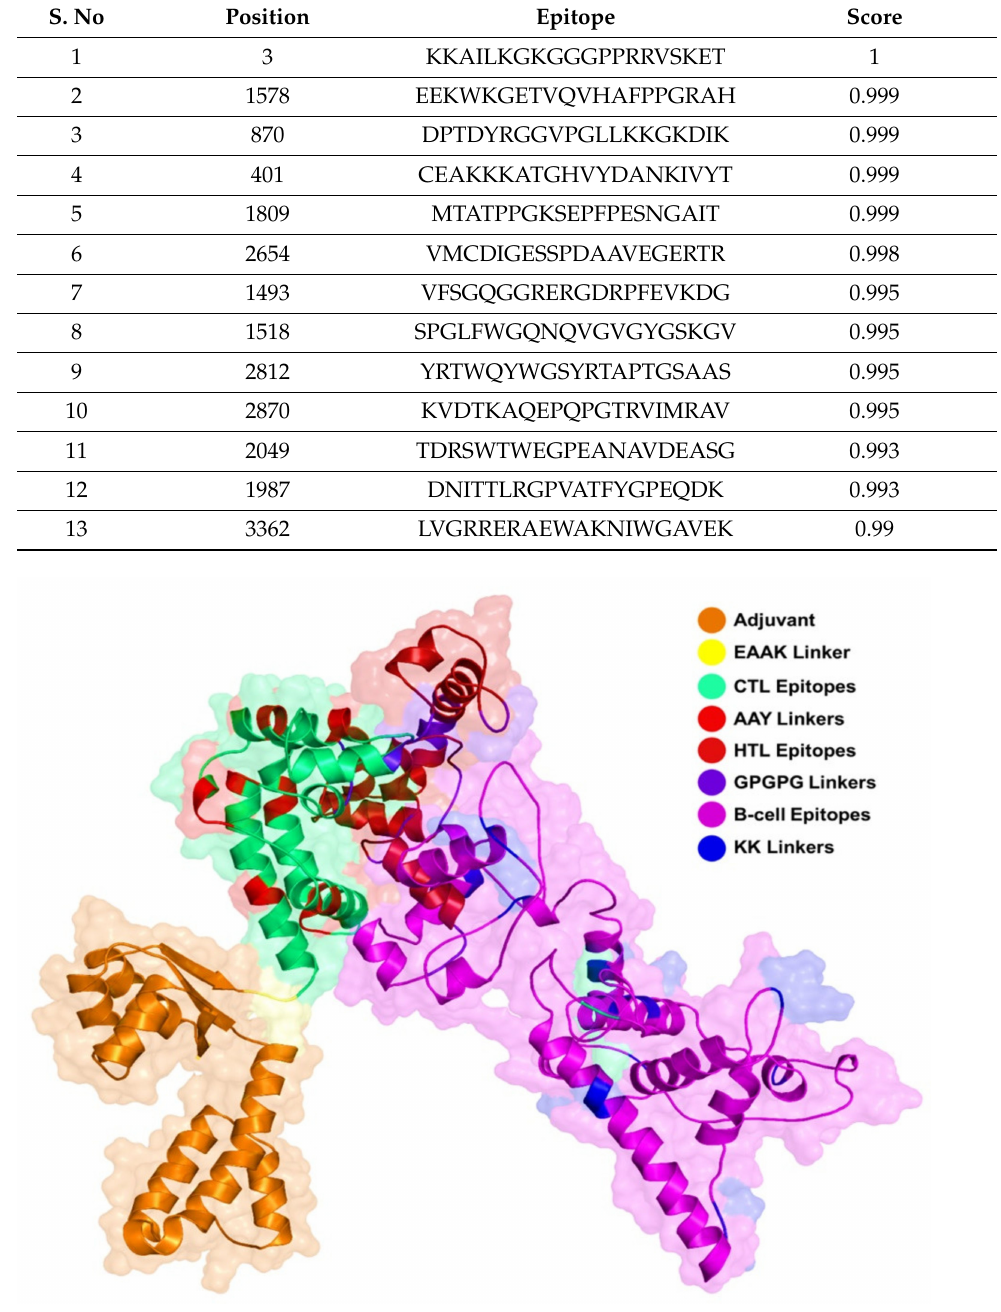
Figure 2. Showing each component of the final vaccine. Adjuvant, linkers, CTL, HTL, and B-cell epitopes are colored